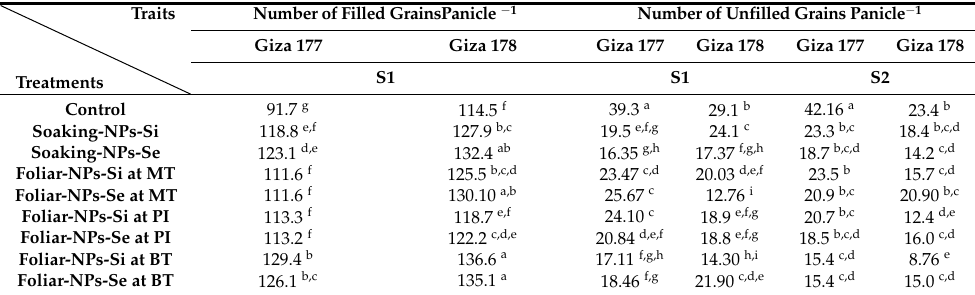
Table 8. Effect of the interaction between NPs-Si, NPs-Se, and rice varieties on the number of filled and unfilled grains panicle − 1 in the 2018 (S1) and 2019 (S2) seasons.